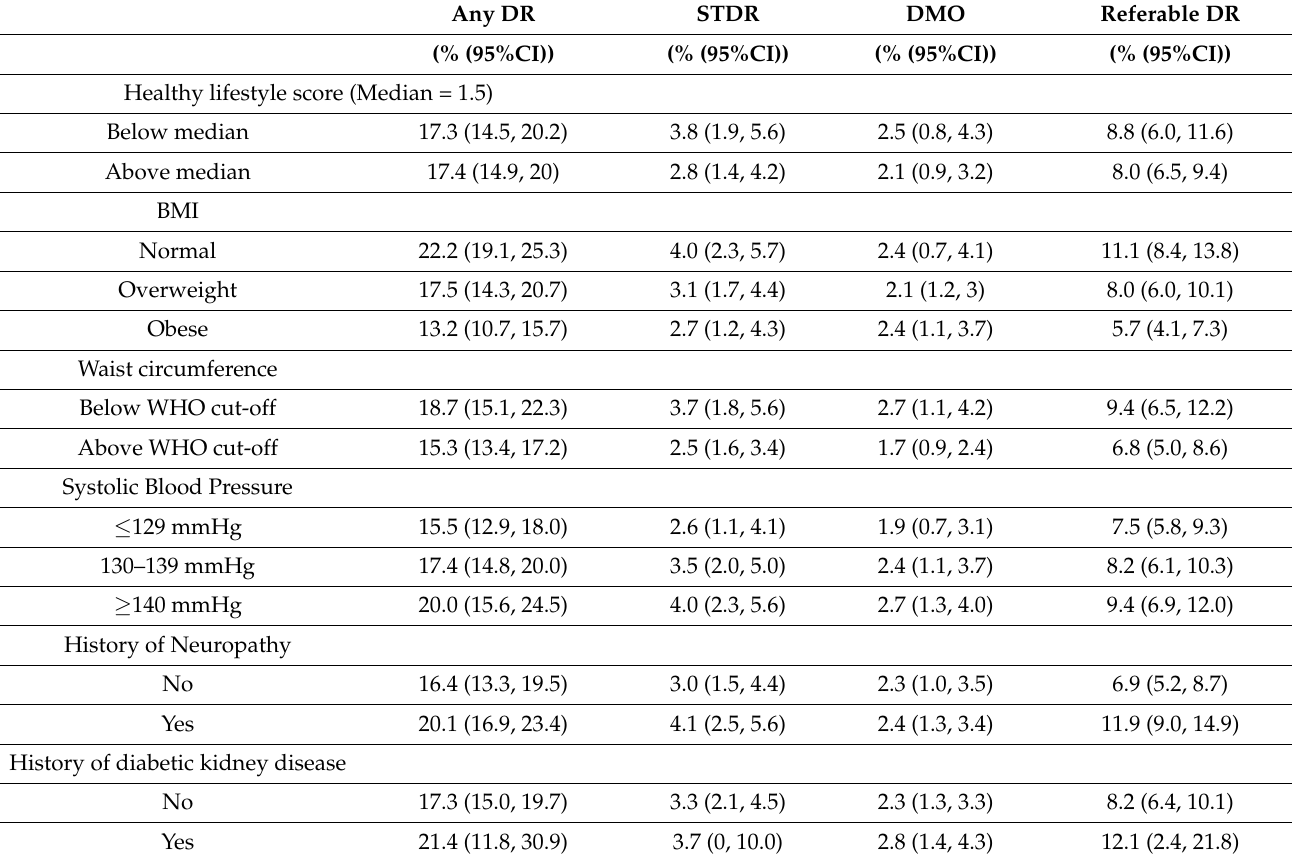
Table 5. Age- and gender-standardised prevalence of DR according to lifestyle factors ( N = 4527). Any